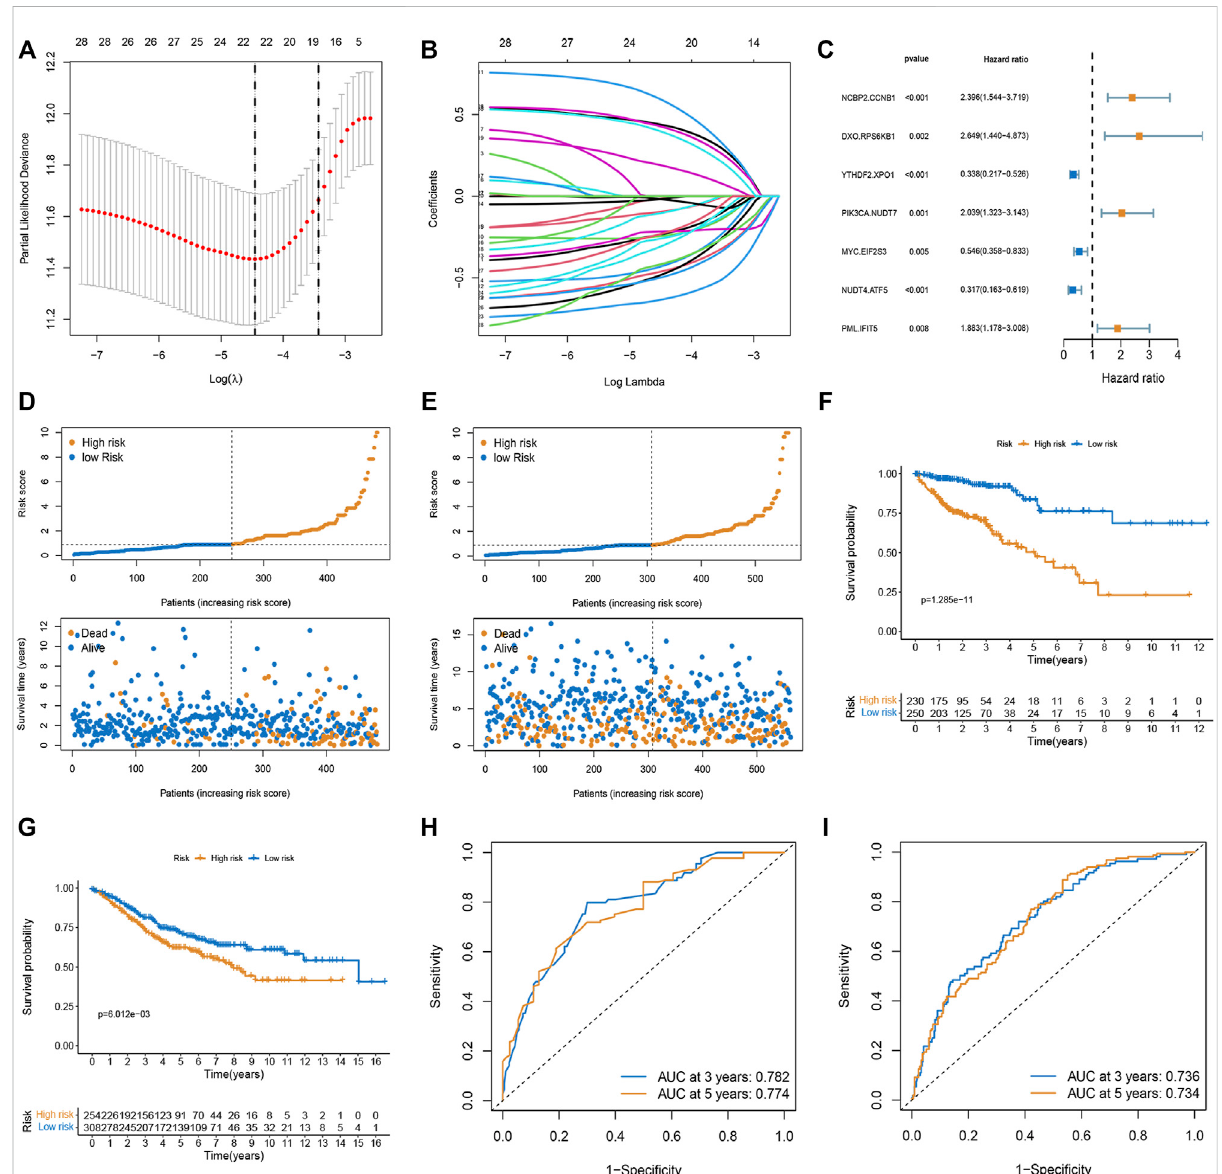
FIGURE 1 Construction and validation of the prognostic model based on m7G-related gene pairs. (A) Plot indicating the optimal λ selection by 10 cross- validated partial likelihood deviance of the LASSO-Cox regression. 10-fold cross-validated partial likelihood deviance was plotted against log( λ ). (B) Plot of estimated coef fi cients from the LASSO-Cox regression against log( λ ). Finally, 22 non-zero m7G pairs were selected. (C) Constructing a stepwise Cox proportional hazards model. (D,E) The distribution of each patient ’ s risk score ordered from low to high in training and validation sets.Patientsaredividedintotworiskscorelevelgroups.ScatterdiagramoftheOS-timeagainstthepatients ’ rankofriskscoreintrainingandtesting sets. (F,G) Overallsurvivalcurvesofdifferentrisksubgroupsinthetrainingandvalidationsets. (H,I) AUCcurvestopredictthesensitivityandspeci fi city of 3- and 5-year survival according to the risk score in training and validation